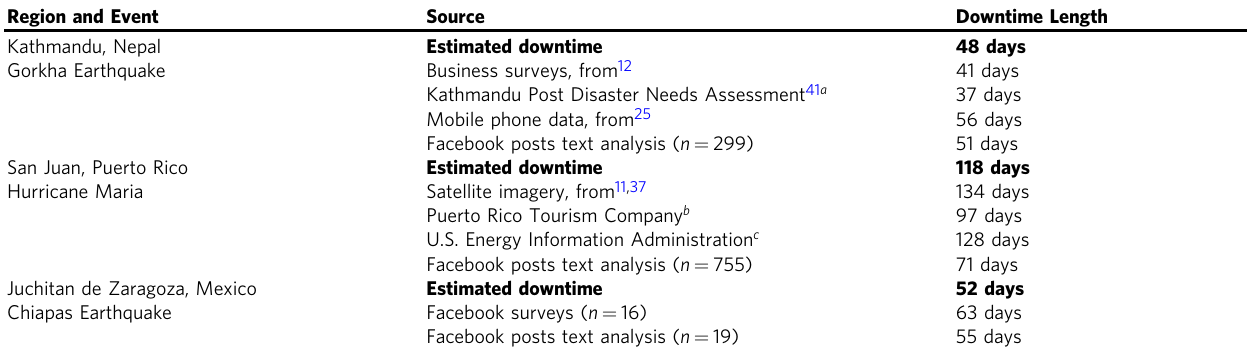
Table 2 Validation sources for the proposed framework. Downtimes estimated with the proposed framework (Estimated downtime) for the three natural hazard events considered, along with the downtimes reported by the various validation sources described in Methods.